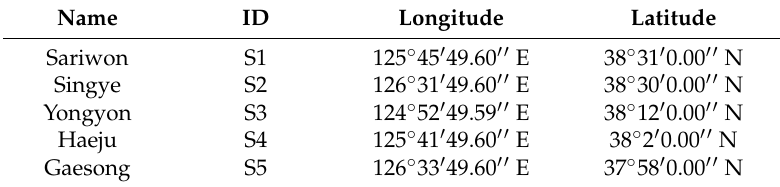
Table 1. Descriptions of meteorological stations in the Hwanghae